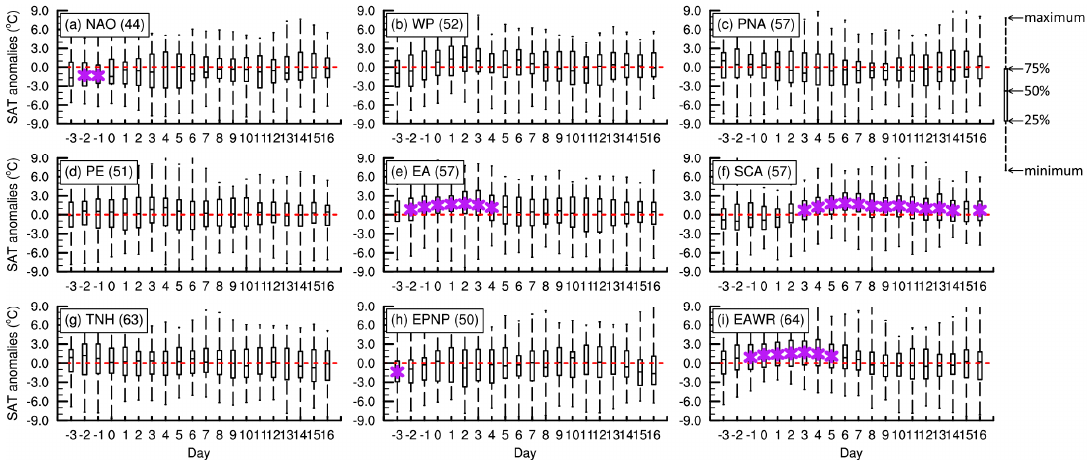
Figure 3. ( a – i ) Same as subfigures (a-i) of Figure 2, respectively, but in the negative phase of the nine teleconnection